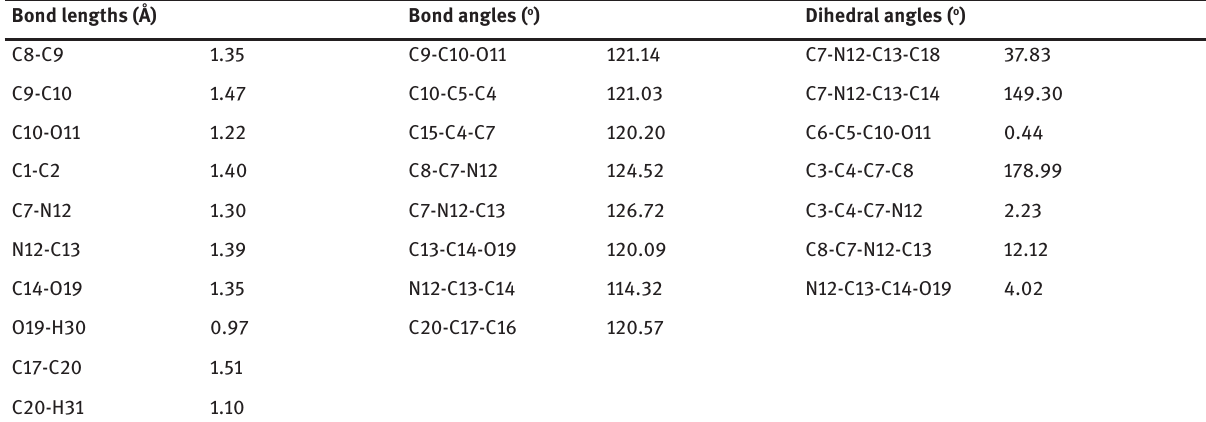
Table 1: Representative bond lengths, bond and dihedral angles of PINQ